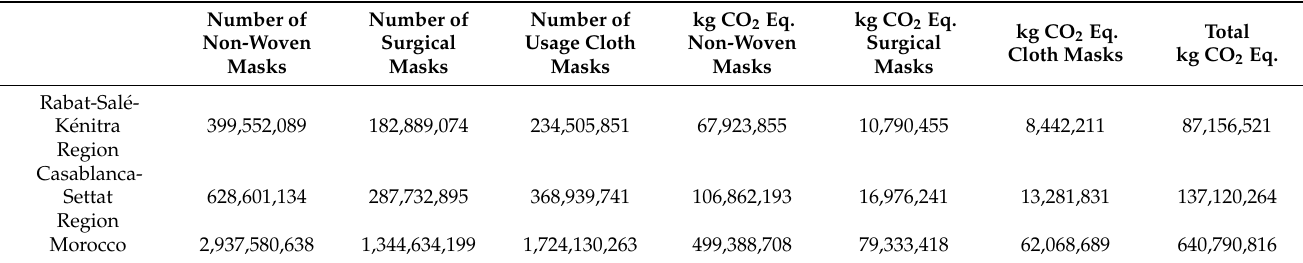
Table 3. Annual GHG footprint calculated for the studied regions: Rabat-Sal é -K é nitra and Casablanca-Settat, and Morocco according to the results of the present study.